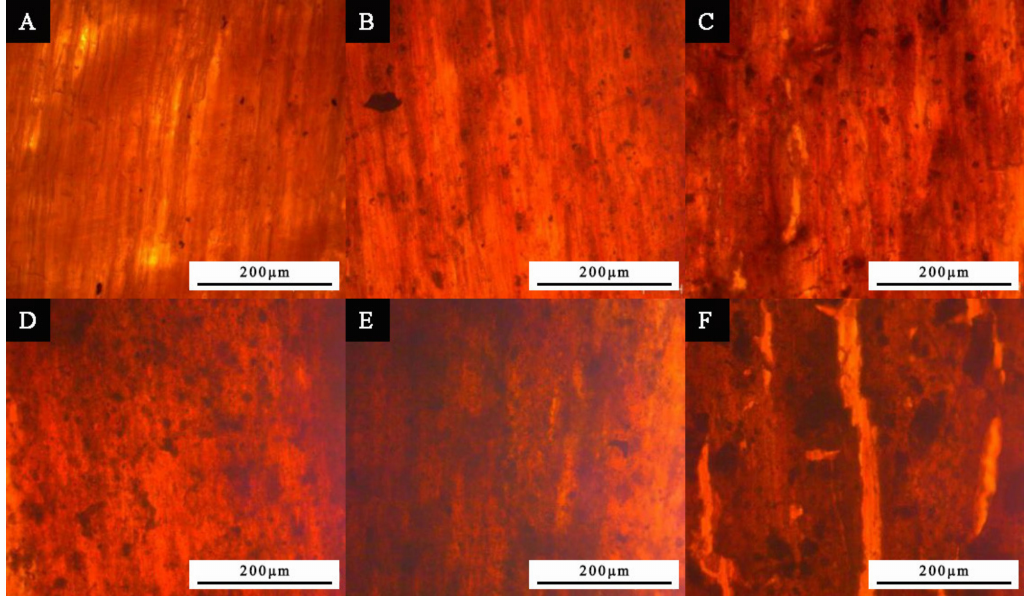
Figure 4. Microstructure of paint film with different contents of micron silver particles: ( A ) 1.0%, ( B ) 4.0%, ( C ) 7.0%, ( D ) 10.0%, ( E ) 13.0%, and ( F )